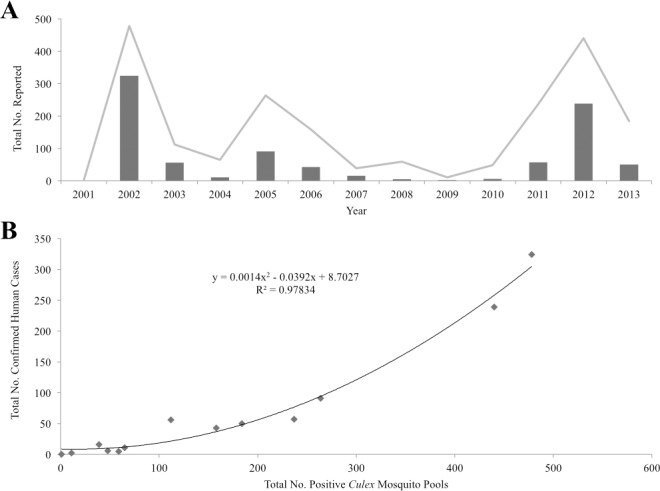
WNV human case prevalence and number of recorded Culex mosquito pools in Ontario, Canada from 2002 to 2013.(A) Comparison of confirmed WNV human cases and positive Culex mosquito pools recorded each year. Solid line represents WNV positive Culex mosquito pools. Bars represent confirmed WNV human cases. (B) Same data as in (A). A strong (R2 = 0.9783, p < 0.001) quadratic relationship between the total number of human cases and positive Culex pools recorded at the end of each field season in Ontario, Canada was observed.